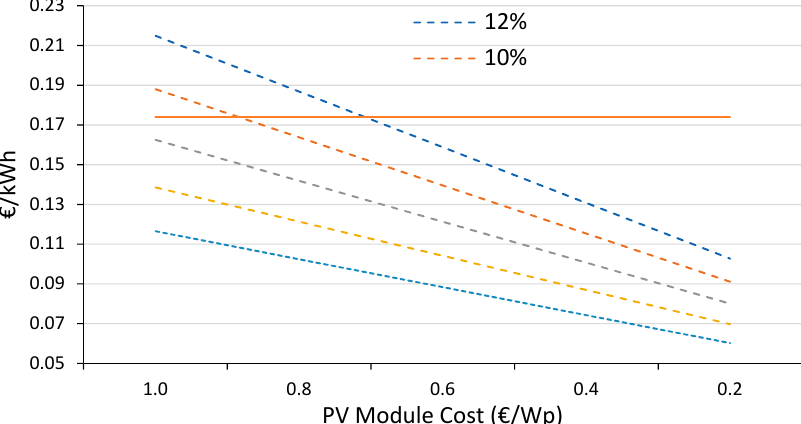
Figure 15. Analysis of the LCOE against the retail electricity cost at various interest rates (500,000 W inverter, deterministic method).